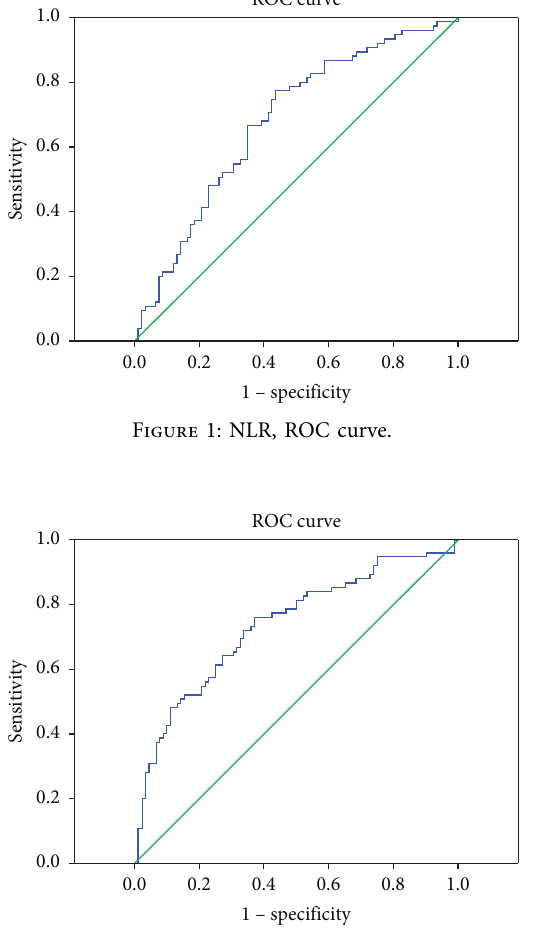
Figure 2: PLR, ROC